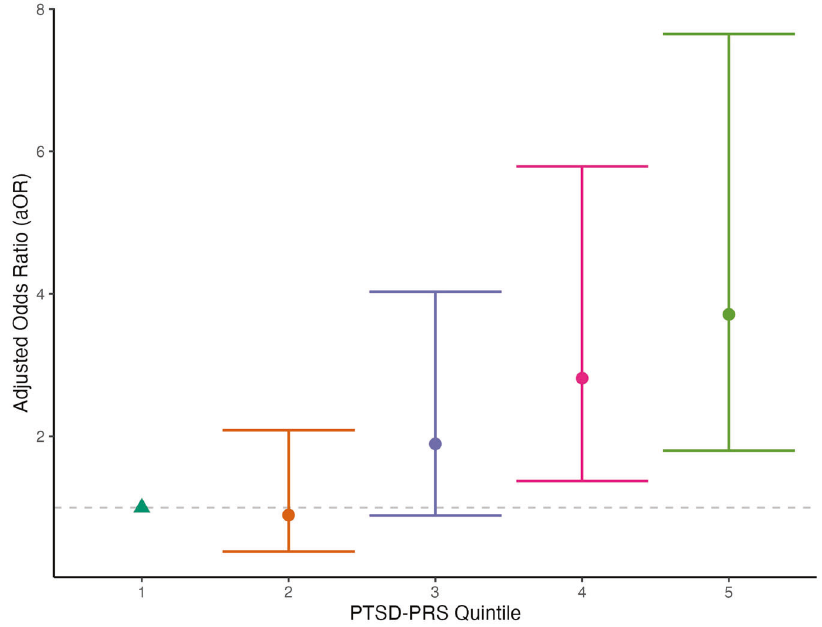
Fig. 1 Adjusted odds ratio (and 95% CI) for 6-months PTSD by PTSD-PRS quintiles. Dots indicate the point estimate for adjusted odds ratio (aOR) and the lines emanating from the dots indicate the upper and lower 95% con fi dence intervals. The triangle indicated an aOR of 1 for the lowest quintile, which is the category to which the other quintiles are